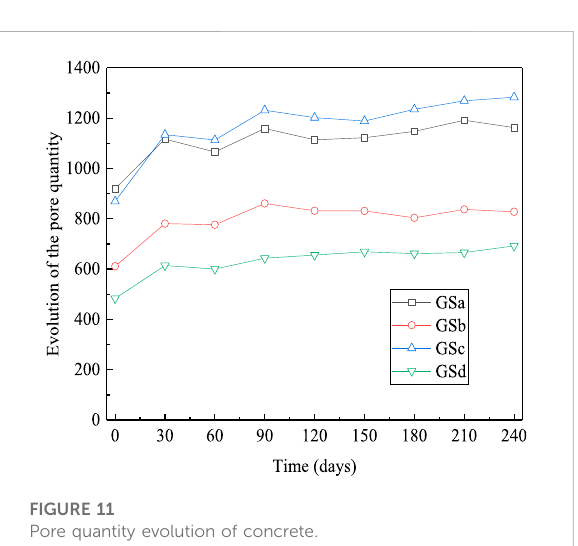
FIGURE 10 Evolution of the porosity.